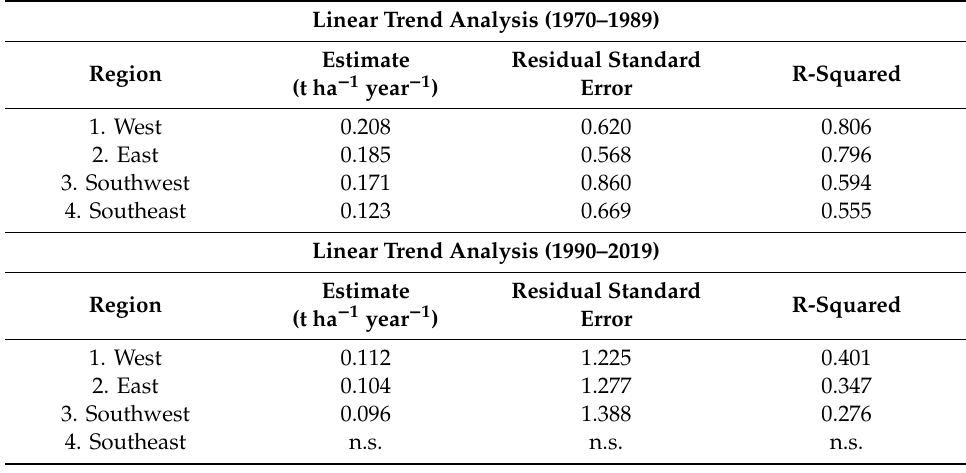
Table 2. Results of the annual linear trend analysis of yield changes.